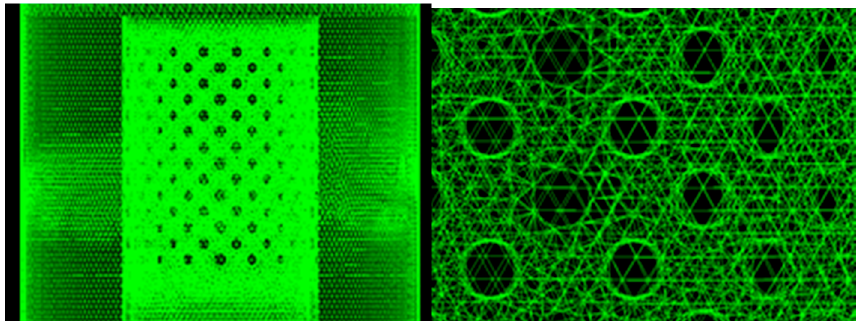
Figure 4. Schematic diagram of the local grid.